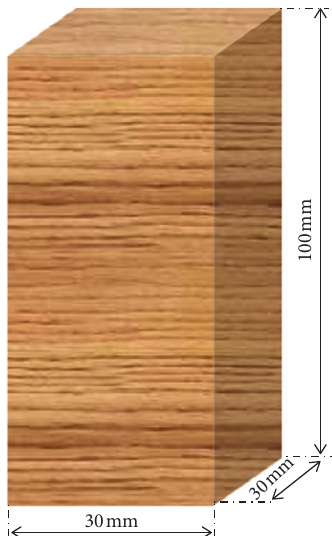
Figure 3: Standardized compression specimen [10].